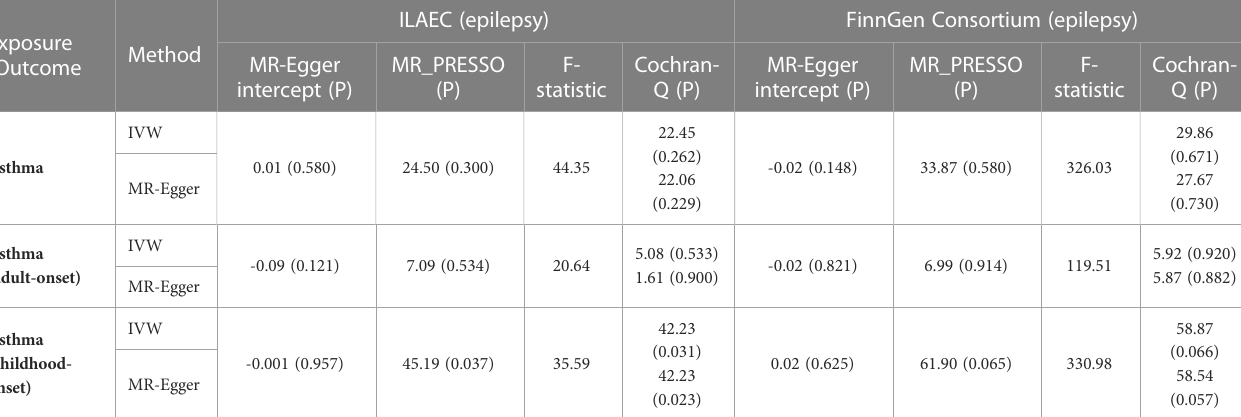
TABLE 2 Heterogeneity and power analysis of asthma on epilepsy.